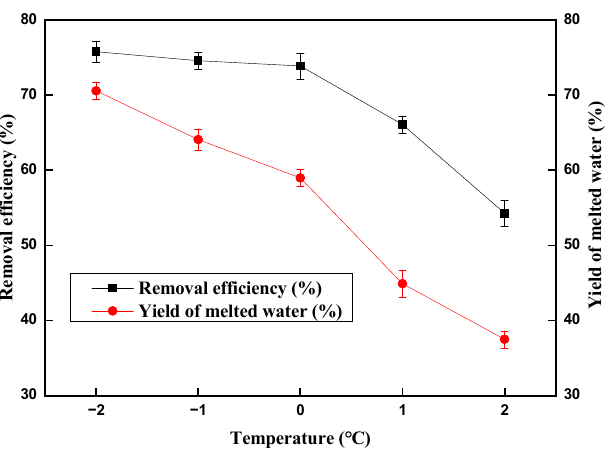
Figure 2. Effect of temperature on the removal of copper (II) ions and the yield of melted water.